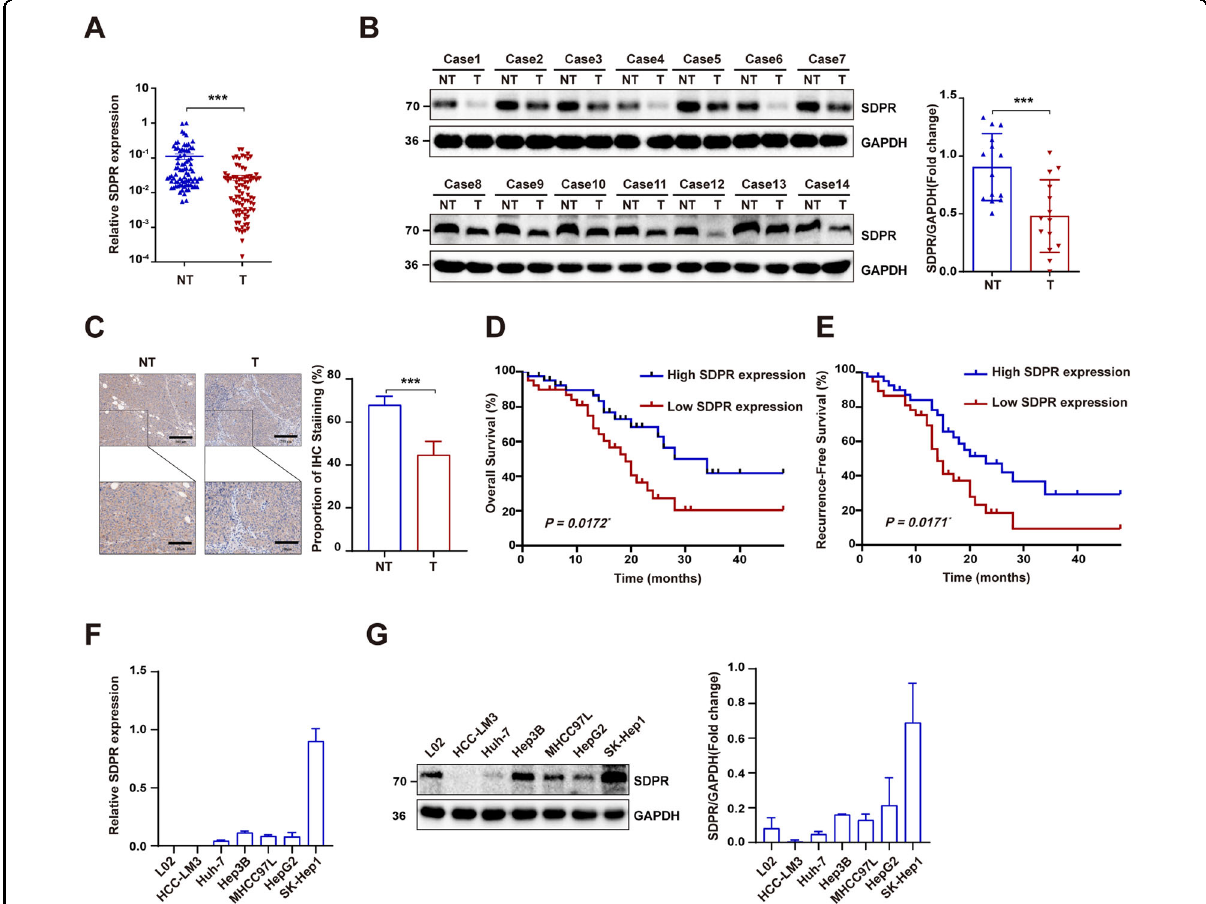
Fig. 1 SDPR expression was reduced in HCC and predicted poor prognosis. A SDPR expression was downregulated in HCC tissues compared to non-tumor tissues, identi fi ed by the qRT-PCR analyses of HCC samples of 81 patients. B The level of SDPR protein was observed in 14 sets of human HCC cancers tissues and peritumor tissues. C SDPR immunohistochemistry (IHC) stain in clinically identi fi ed HCC tumor samples and adjacent non- tumor samples. D , E Kaplan – Meier analysis of overall survival (OS) and recurrence free survival (RFS) in 81 HCC patients from our hospital. F , G Relative SDPR mRNA and protein expression level in six human HCC cell lines: HCCLM3, Huh-7, Hep3B, MHCC97L, HepG2, SK-Hep1, and normal liver cell L02. * p < 0.05; *** p < 0.01; *** p <